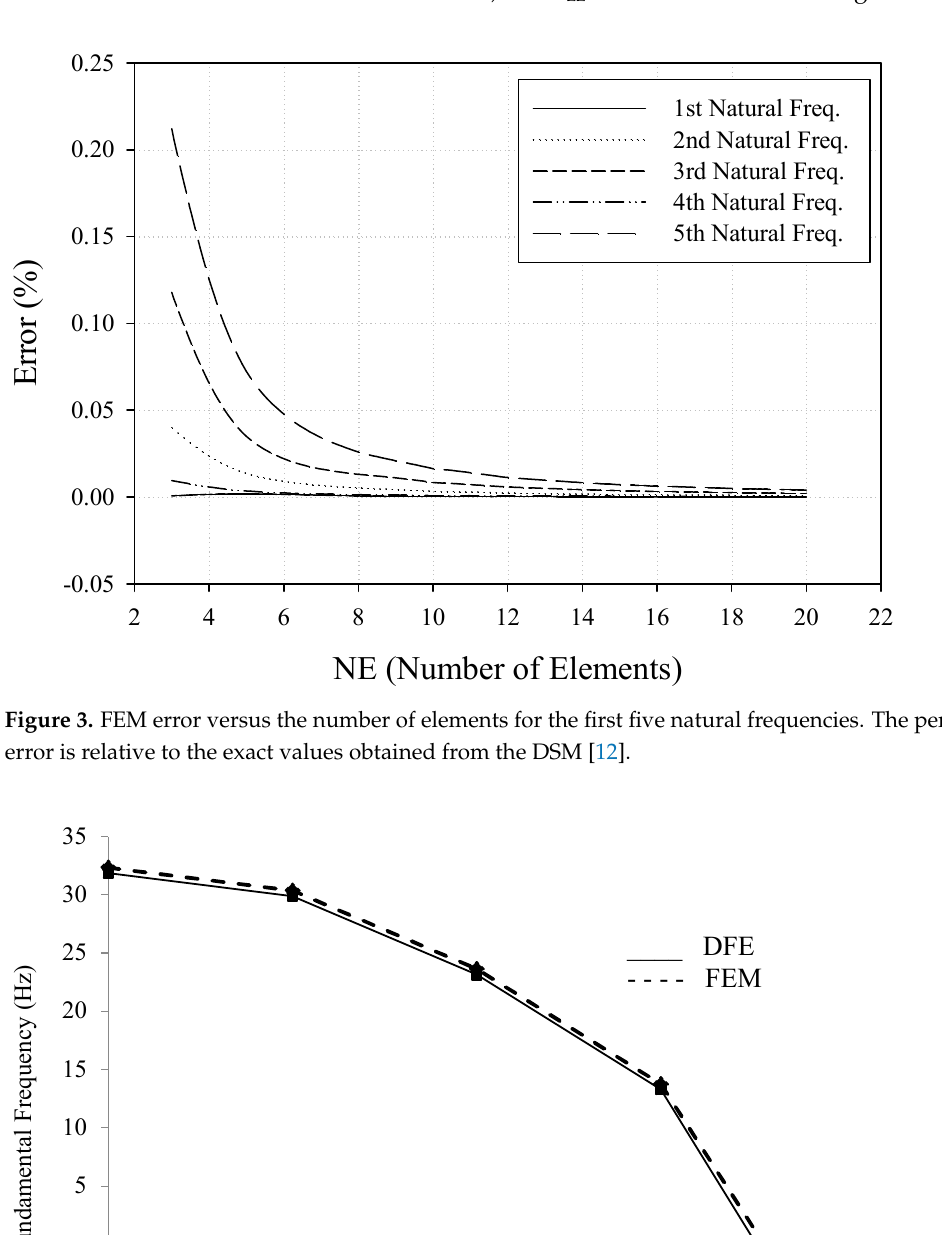
Table 1. Comparison of the first five FEM and DFE natural frequency (Hz) results for M zz = 0 and P = 0 with the analytical DSM values [12].